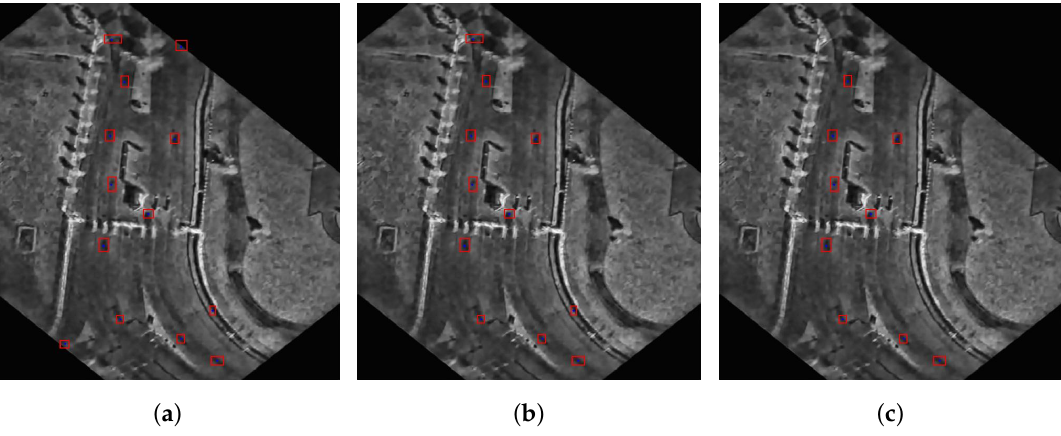
Figure 8. False alarm reduction results of the 369th frame. ( a ) Description of pre-detection result. ( b ) Description of false alarm reduction result via unweighted edge detection. ( c ) Description of false alarm reduction result via gradient-weighted edge detection. Red blocks represent detected